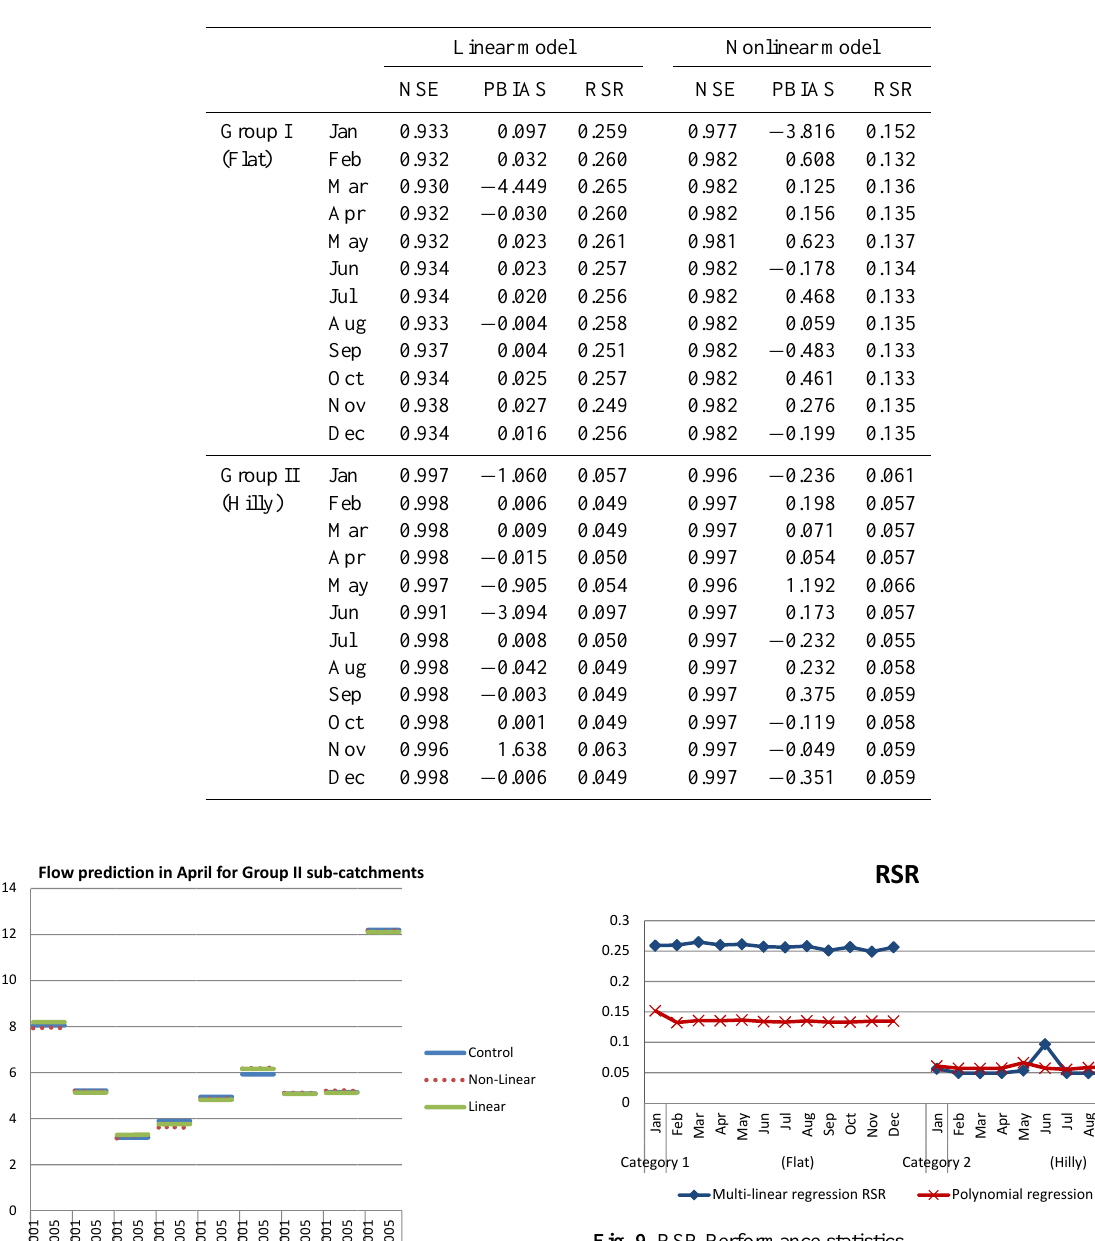
Table 7. Dimensionless Performance statistics (NSE, PBIAS, RSR).